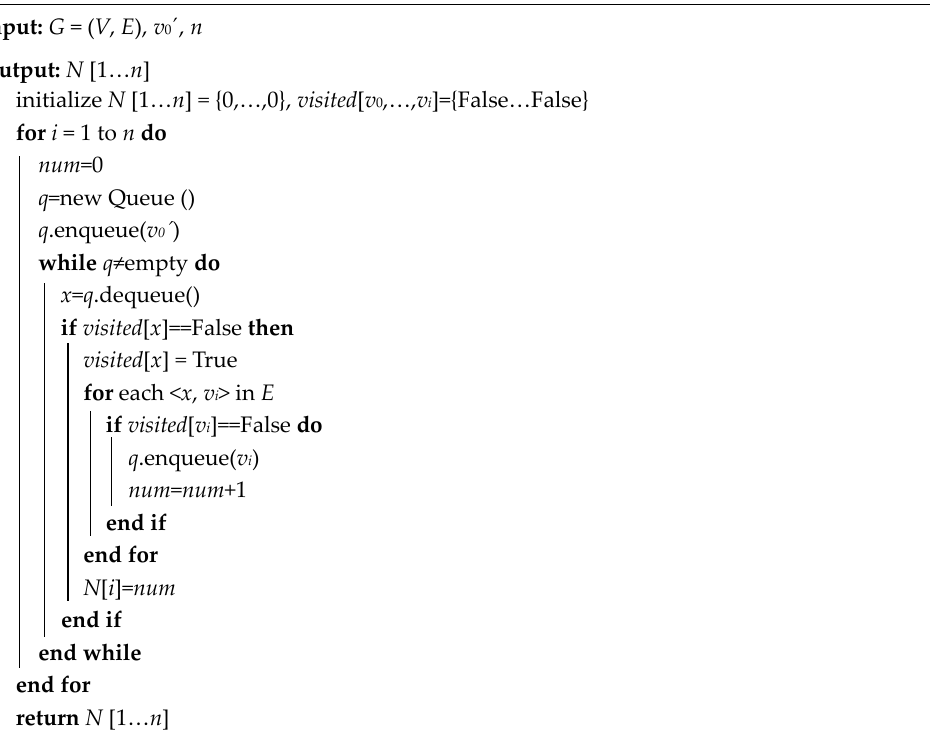
Algorithm 2 Calculating the vector of the number of neighboring nodes within n hops